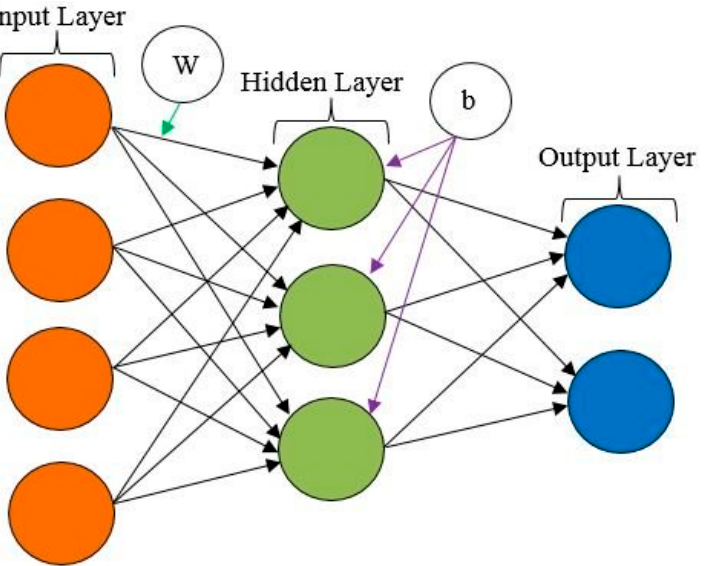
Figure 3. A typical neuron from an artificial neural network (adapted from Rahman, M. A., R. C. Muniyandi, K. T. Islam, and M. M. Rahman [27]).